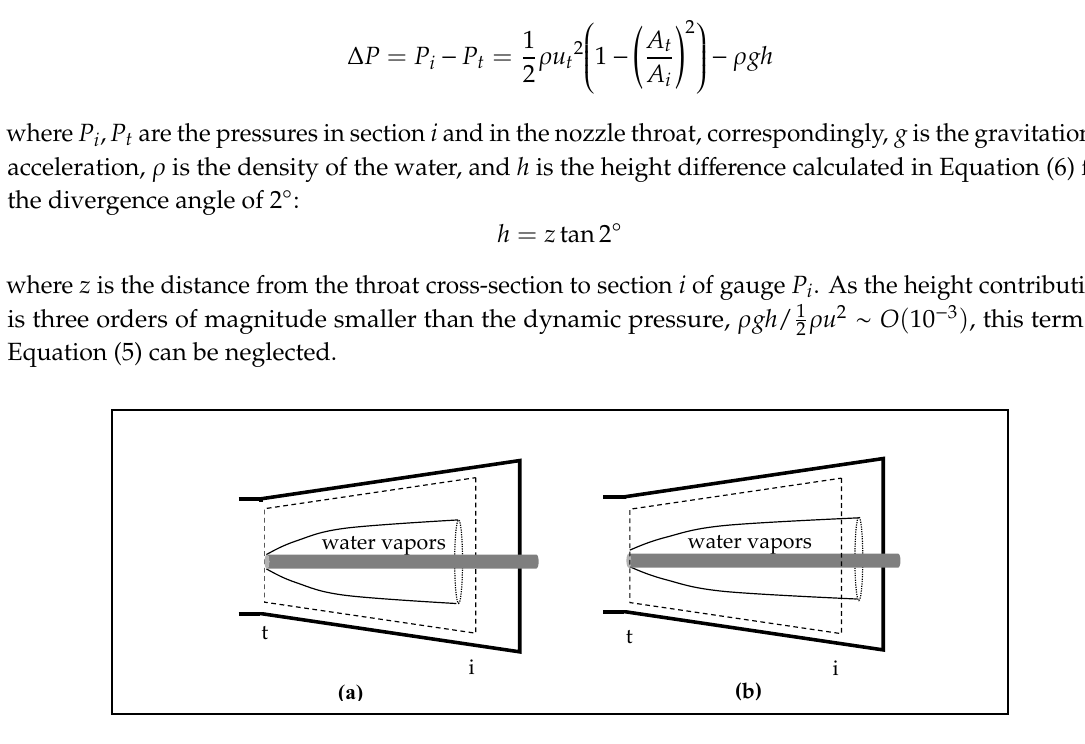
Figure 8. Control volume for theoretical analyses. ( a ) the cavitation does not reach the cross-section ( b ) the cavitation reaches the cross-section.